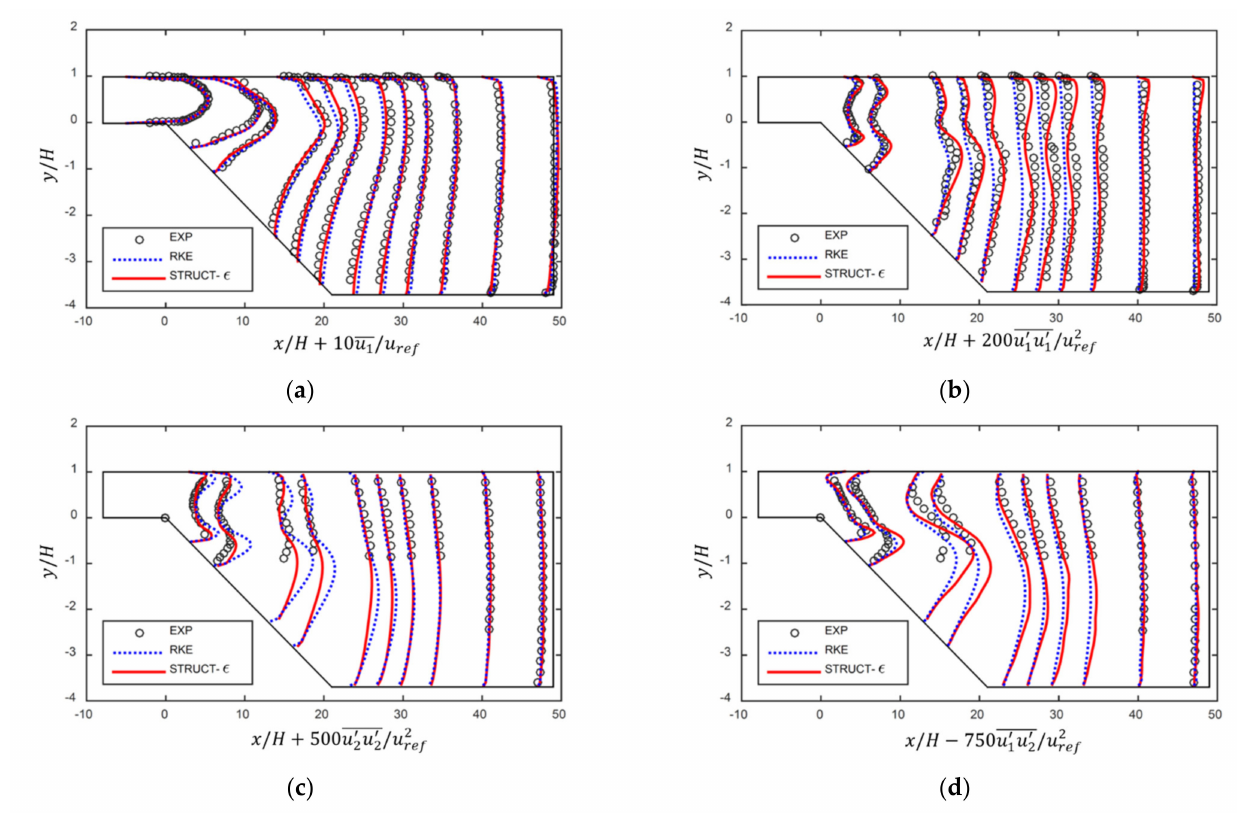
Figure 5. Comparison of ( a ) mean streamwise velocity profiles, ( b ) streamwise turbulent stress profiles ( u 1 (cid:48) u 1 (cid:48) ), ( c ) transverse-normal turbulent stress profiles ( u 2 (cid:48) u 2 (cid:48) ), ( d ) turbulent shear stress profiles ( u 1 (cid:48) u 2 (cid:48) ), between the RKE and STRUCT- ε models and the experimental data [34] in the xy symmetry plane of the asymmetric